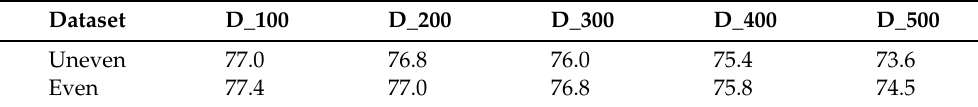
Table 5. Unevenly VS evenly distributed samples: kNN evaluation.